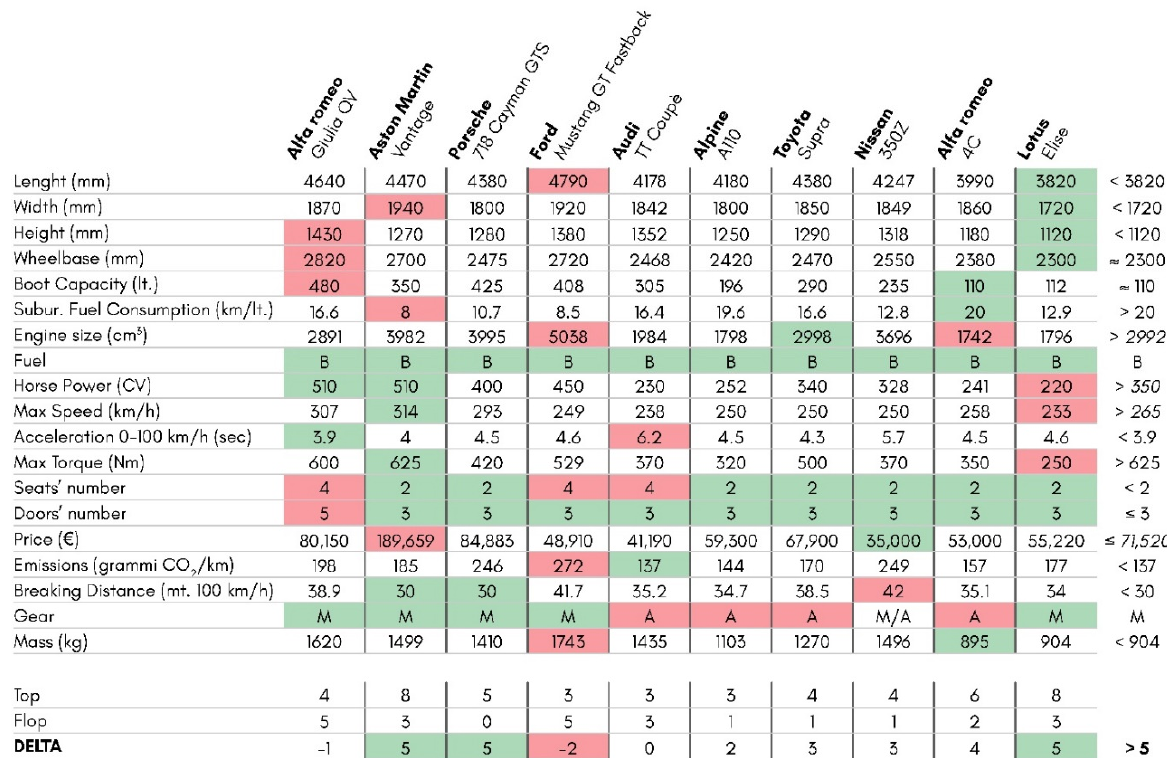
Figure 9. Benchmarking table amongst concurrent productsAt the right-bottom corner we can find one of the most important indicators of the whole analysis. This value represents the minimum number of technological advancements that the design needs to be considered innovative. In the present case study, a minimum of 5 improvements over the competition needs to be achieved.